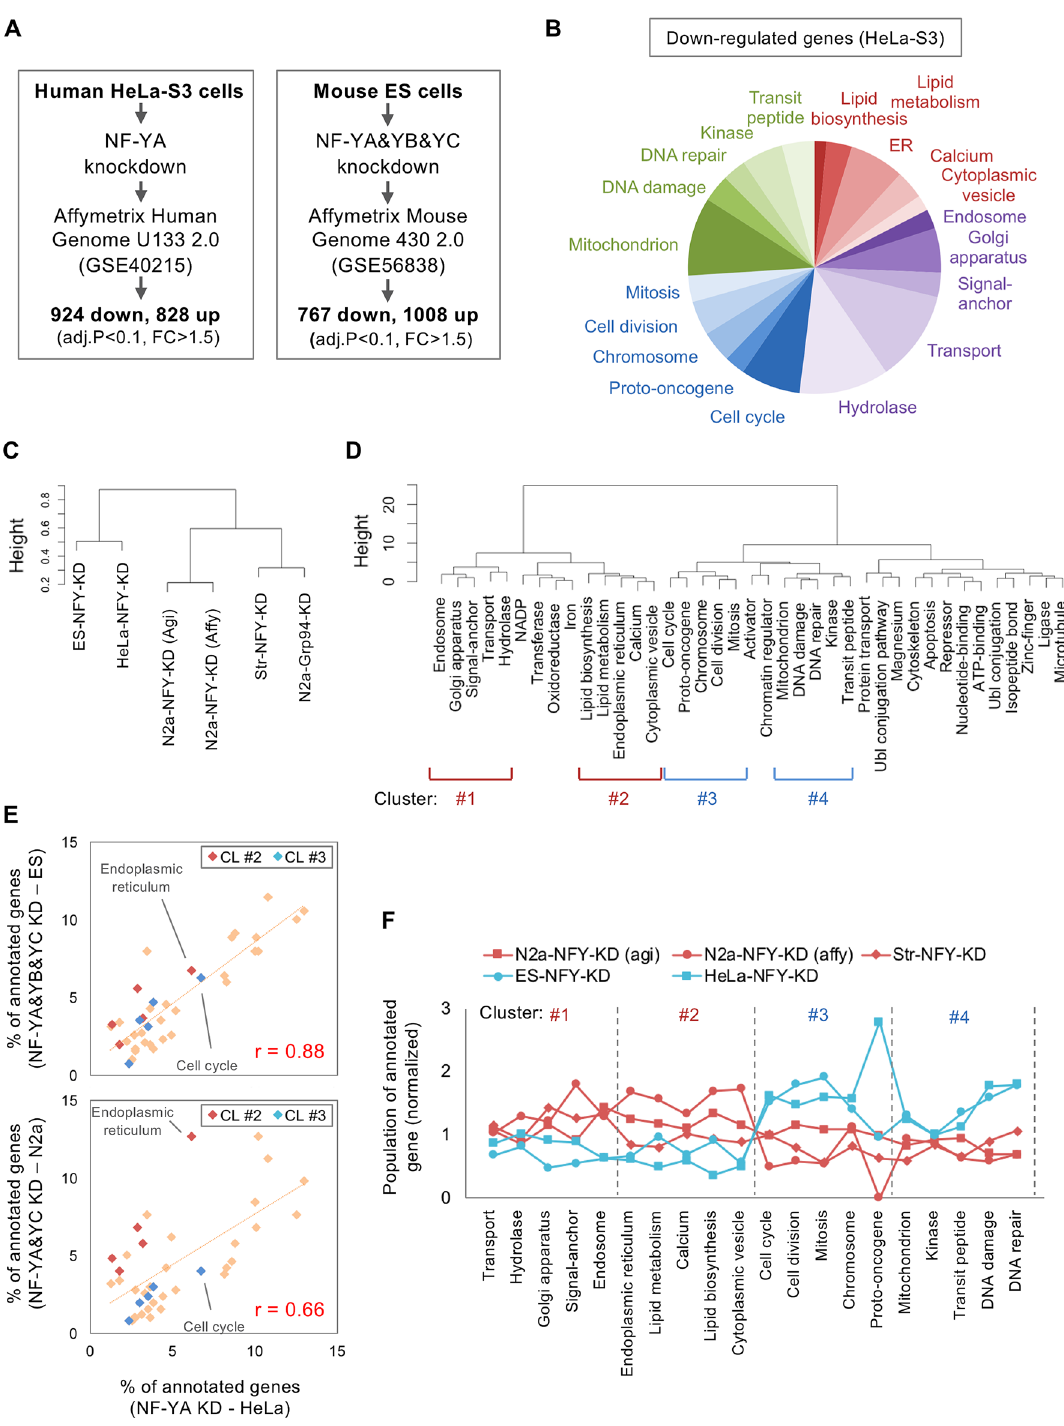
Figure 4. DNA microarray analysis of NF-Y knockdown HeLa and ES cells. ( A ) Analysis of DNA microarray data for HeLa cells with NF-YA knockdown or mouse ES cells with NF-YA, -YB and -YC triple knockdown identified 1752 (924 down, 828 up) or 1775 (767 down, 1008 up) DEGs, respectively. ( B ) Pie graph for the populations of annotated genes down-regulated in NF-YA knockdown HeLa cells. High enrichment was observed for cell cycle genes in these cells. ( C , D ) Hierarchical clustering of the analyzed cells based on the population of annotated genes (Ward.D2 method). ( C ) Clustering of the cells. HeLa and ES cells were in a same cluster and far from those of N2a/striatal cells. ( D ) Clustering of functional terms used for gene annotation. Clusters containing endosome/Golgi (CL #1), ER/lipid metabolism (CL #2), cell cycle/mitosis (CL #3) or mitochondrion/DNA damage (CL #4) were observed. ( E ) Scatter plot for the populations of annotated genes. The correlation was high between HeLa and ES cells (r = 0.88) whereas it was low between HeLa and N2a cells (r = 0.66) especially for those of CL #2 and #3. ( F ) Overall comparison of the populations of annotated genes in CL #1–4. Note that gene populations in CL #1 ~ 2 were relatively high in N2a and striatal cells whereas those for CL #3–4 were high in HeLa and ES